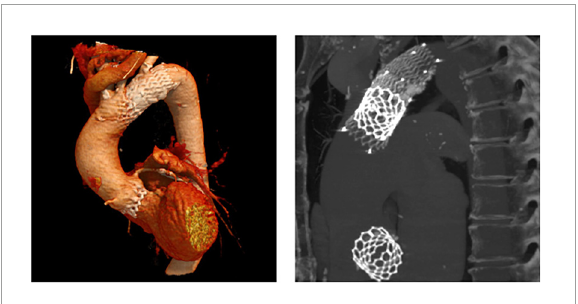
FIGURE5 CT images of a patient with embolization of a Sapien 3. CT follow-up of patient number 7 ( Table 5 ). After embolization due to loss of capture during implantation, the embolized Edwards Sapien 3 was pulled back into the proximal aortic arch by the semi-inflated delivery balloon and affixed using two self-expanding stents.